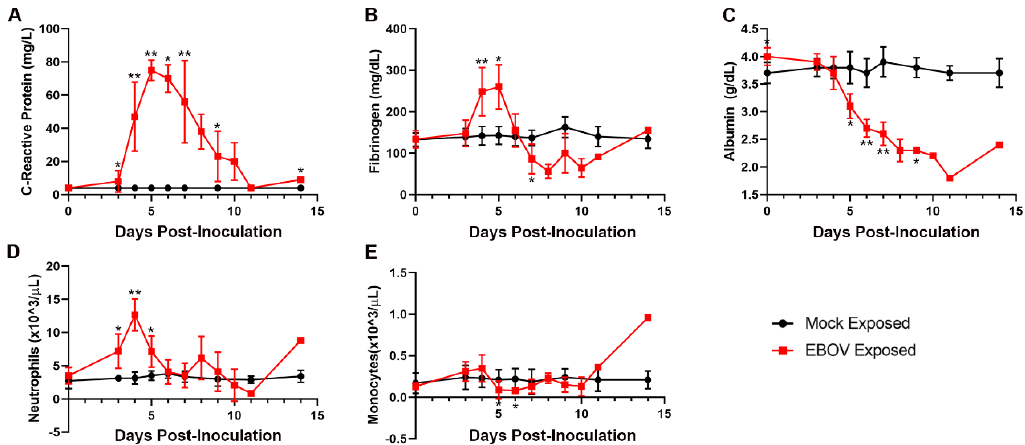
Figure 6. Exposure to IM EBOV in rhesus macaques produces clinical pathology alterations indicative of systemic inflammatory responses. Group mean ± SD of: C-reactive protein ( A ); fibrinogen ( B ); albumin ( C ); neutrophils ( D ); and monocytes ( E ). X-axes are truncated to highlight responses occurring from the first sampling point through the acute disease phase. * p < 0.05; ** p < 0.001. p -values are indicated for comparison of change-from-baseline values in mock- vs. EBOV-exposed animals on the indicated study day. C-reactive protein values < LLOQ (LLOQ = 5 mg / L) were assigned a value of 4 mg / L for display and analysis.